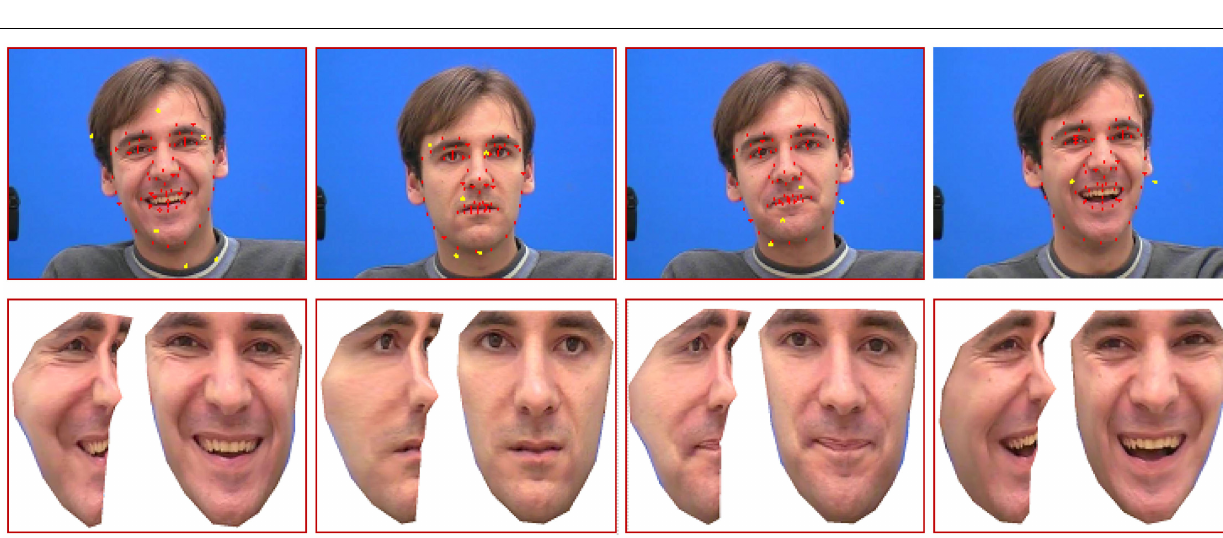
Frontiers in Robotics and AI |